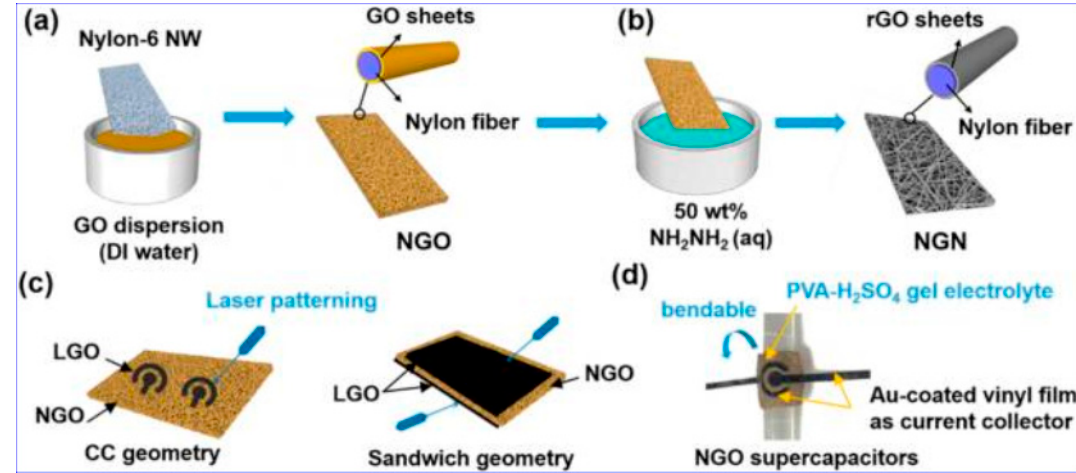
Figure 6. Fabrication process of NGO for conductive and capacitive fabrics ( Reproduced with permission [90] ).